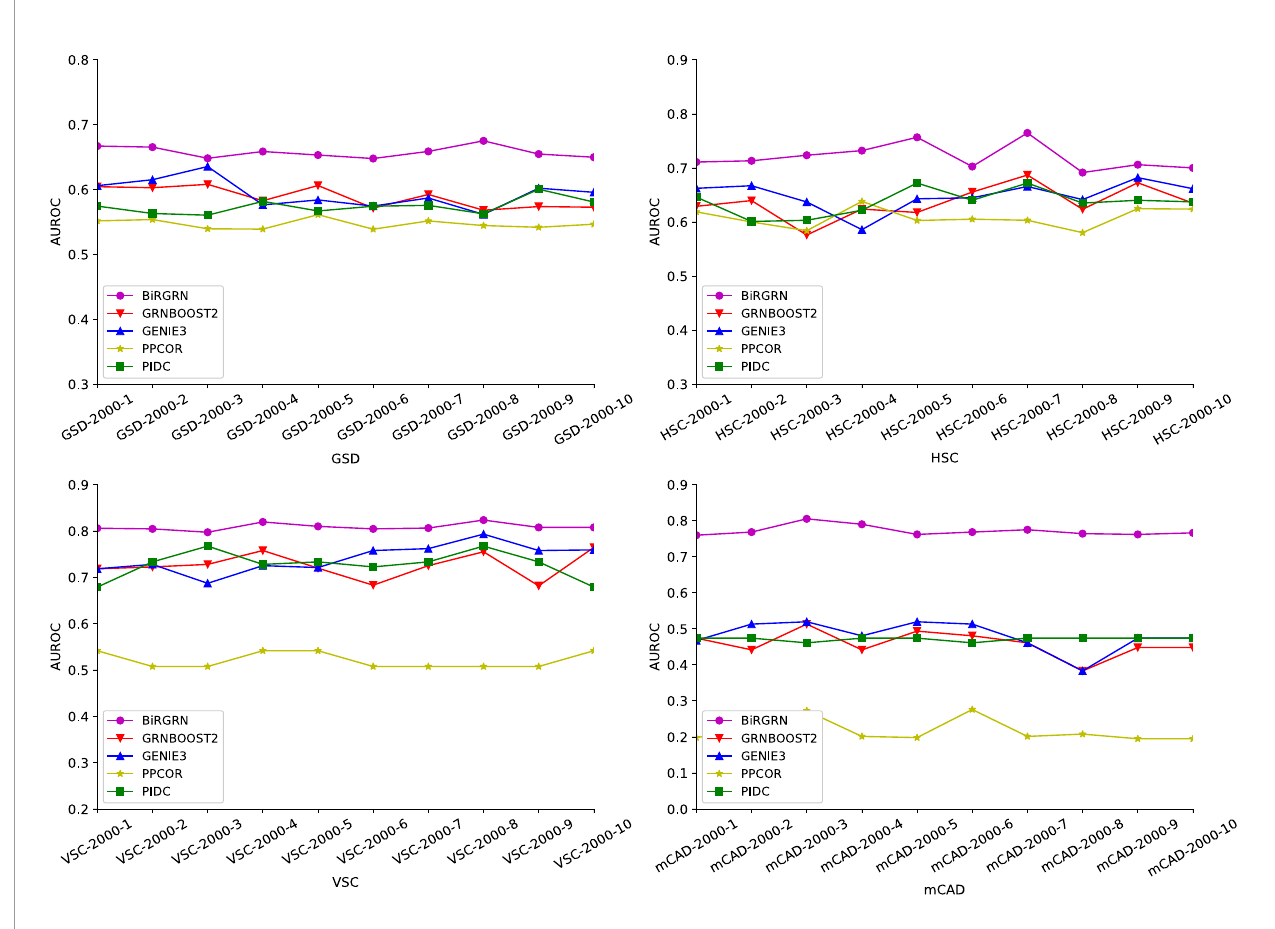
FIGURE 3 | AUROC scores of the compared GRN inference algorithms on four simulated